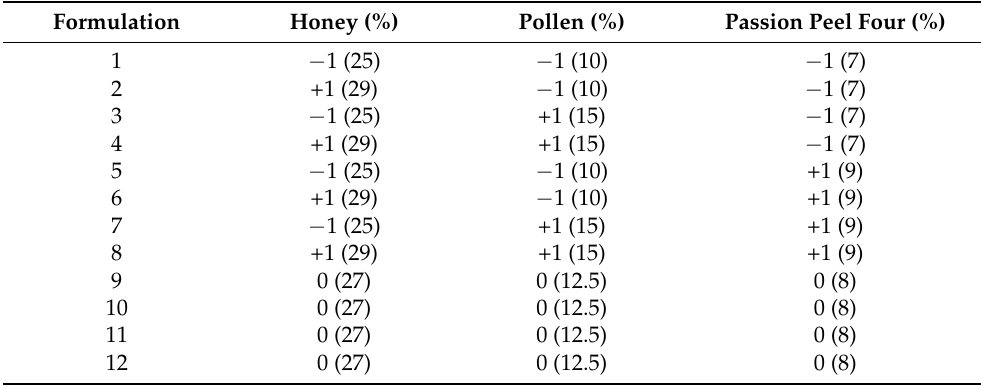
Table 1. Experimental 2 3 factorial design